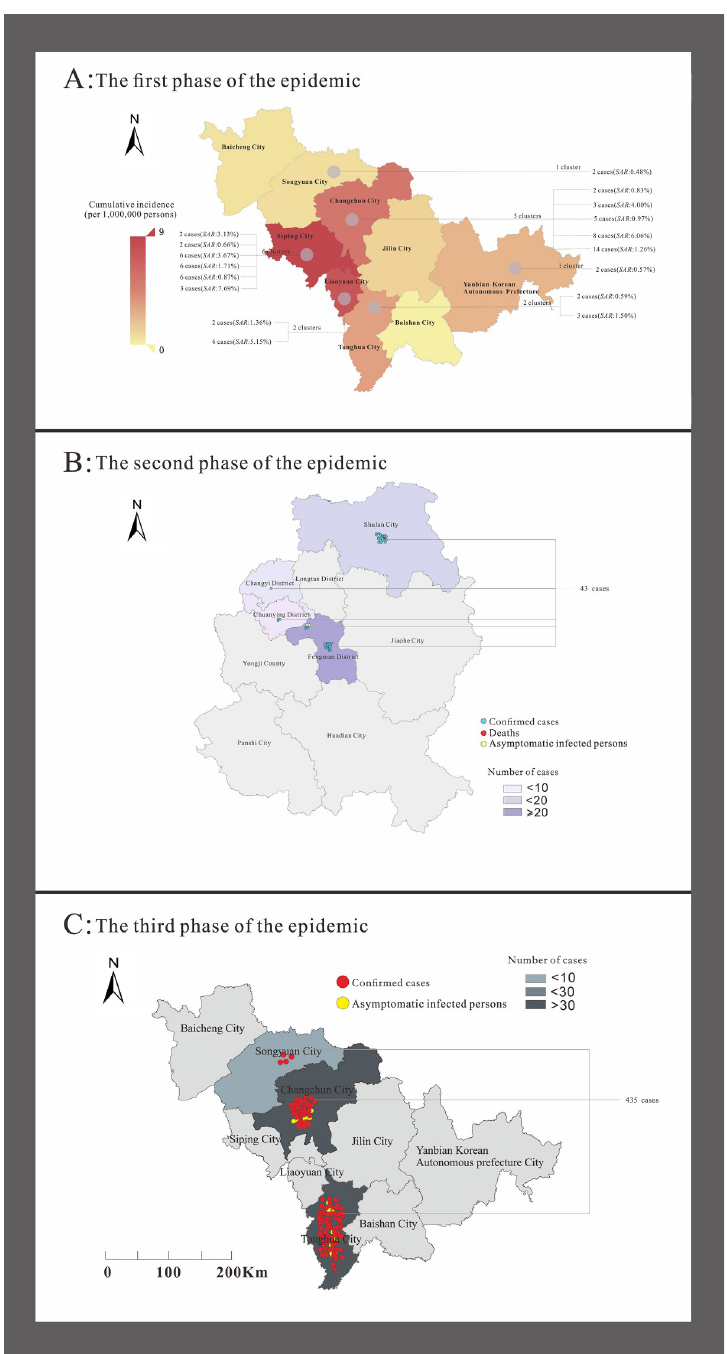
Fig 4. Regional distribution of three phases of COVID-19 outbreaks in Jilin Province. The map depicted in this figure was taken from Datamap (http://datamaps.github.io/).